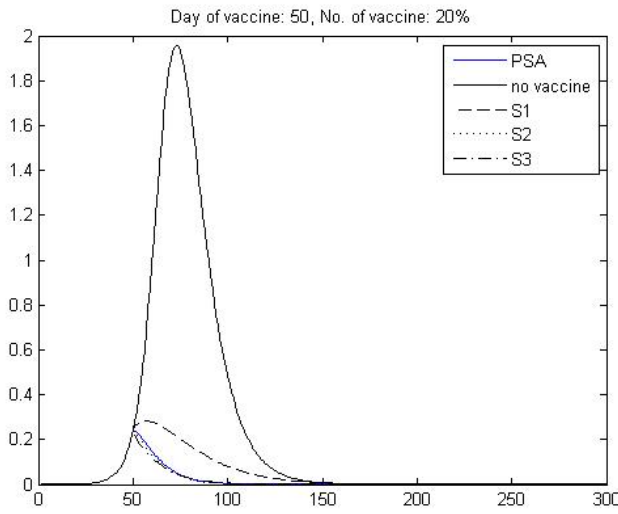
Figure 7. Infection dynamic for 20% vaccination coverage.